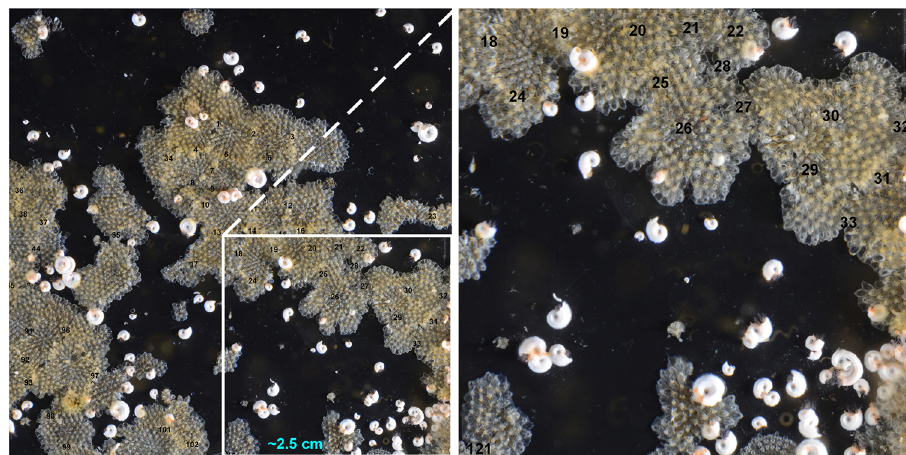
Fig. 4 Example panel area showing spatial competition by bryozoans. Competitive encounters were each marked with a number as they were counted to ensure none were missed or counted twice. The left image is zoomed into one quarter of a panel (image size 4.9 × 4.9 cm) and the right one further zoomed into one-sixteenth of a